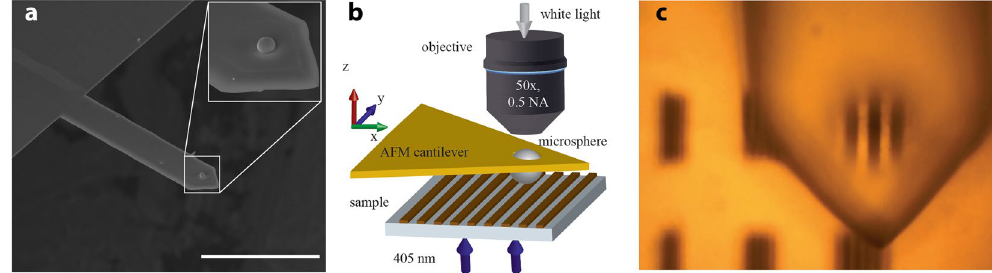
Figure 4. System for translating the microbeads and characterizing the optical response of portable nanojets. ( a ) SEM micrograph of a tip-less AFM cantilever with a microbead electrostatically (Van der Waals interaction) attached to it. Scale bar is 100 µ m. ( b ) Scheme of the optical setup used for enhanced imaging with the microbead. The system could be operated in either reflection or transmission modes. In any case, partially coherent light was used (white light or 405 nm wavelength) and the virtual image formed was collected with a microscope objective. ( c ) Virtual image of a grating formed in reflection mode using a